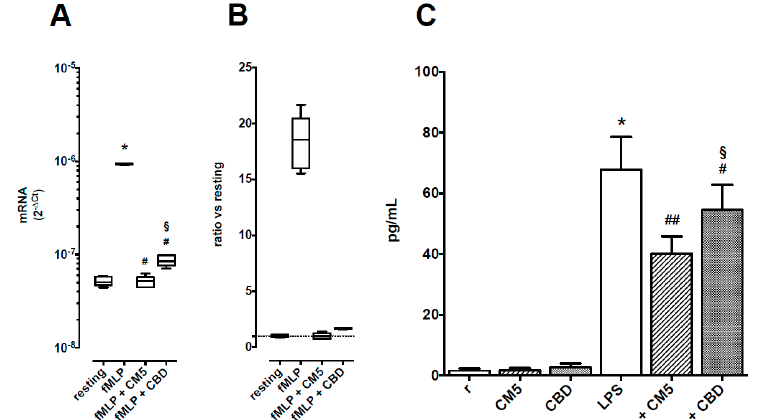
Figure 6. Effects of CM5 50 μ g/mL and CBD 10 μ M on TNF- α production in PMN. Panel A: TNF- α mRNA levels, shown as medians with 25th–75th percentiles (boxes) and min–max values (whiskers) of 5 separate observations. * p < 0.001 vs. resting, # p < 0.001 vs. fMLP alone and § p < 0.05 vs. CM5. Panel B: TNF- α mRNA levels, shown as ratio vs. resting cells. Panel C: TNF- α protein levels in supernatants from cultured PMN. Each column is the mean ± SEM of 10 separate observations. * p < 0.001 vs. resting, # p < 0.05 and ## p < 0.01 vs. LPS alone and § p < 0.05 vs. CM5.